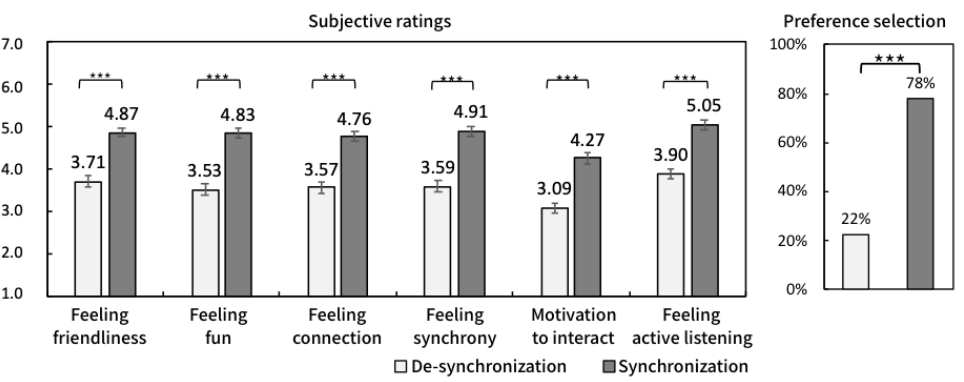
Figure 5. Mean subjective ratings with standard error ( left image ) and preference selection ( right image ); *** p <